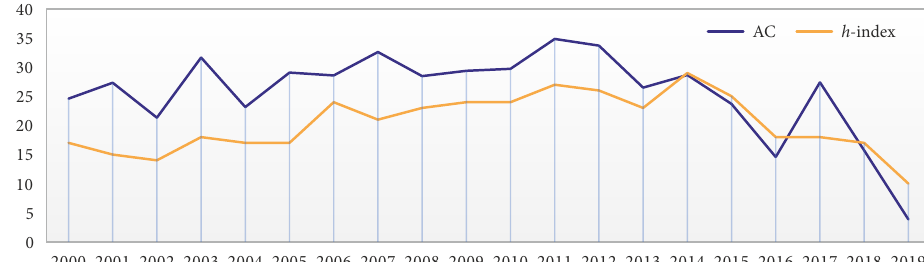
Figure 3. The trends of AC and h -index of publications from 2000 to 2019 in the CACAIE